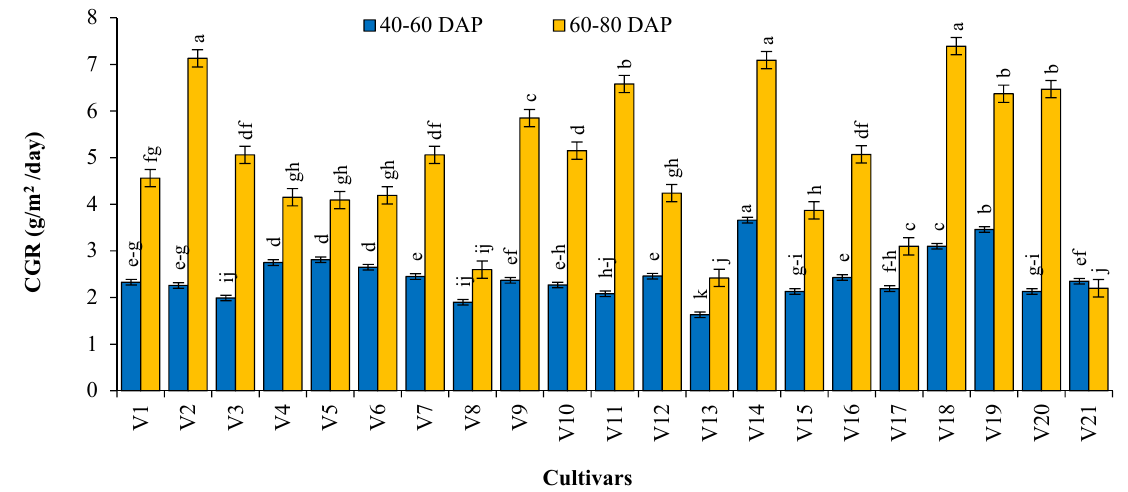
Figure 4. The crop growth rate of different potato cultivars during various stages of growth (two years pooled data); values with different lower case letters are significantly different between each other at the 5% level of significance ( p ≤ 0.05); vertical bars represent standard error of mean values.